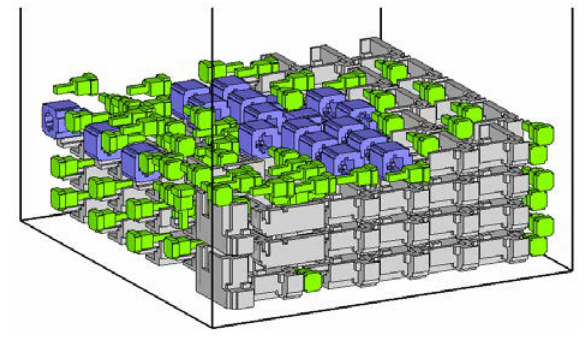
124.4 mm, solution time: 18 seconds).